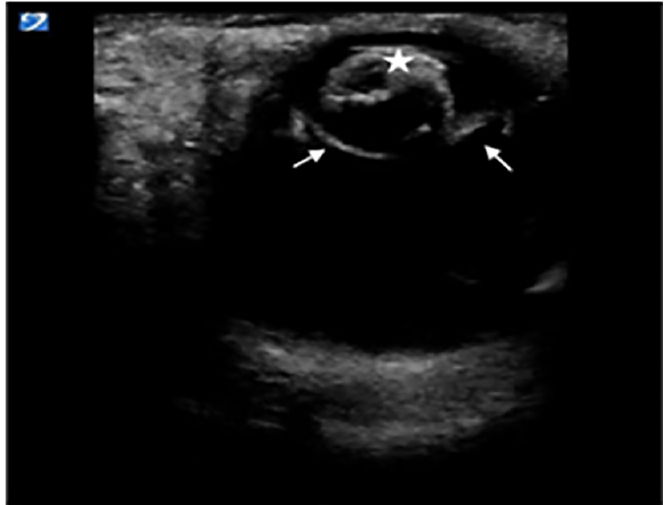
Image 3. Right eye transverse view showing lens (star) displaced anterior to the iris and ciliary bodies